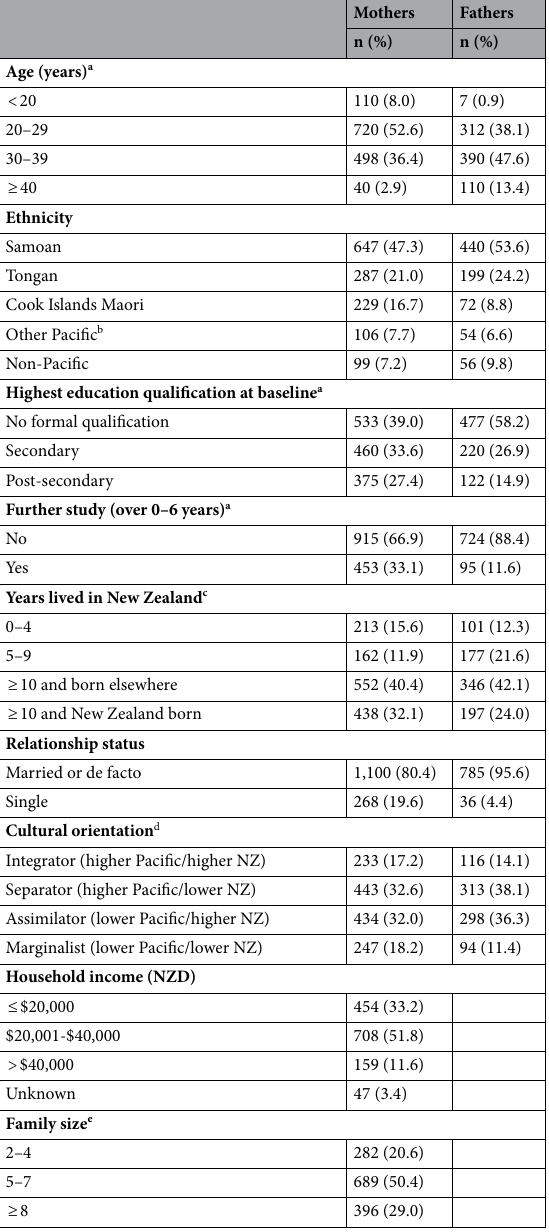
Table 1. Baseline sociodemographic characteristics of mother (6-weeks measurement wave, N = 1,368) and father (12-months measurement wave, N = 821) participants. a 2 (0.2%) values missing for fathers; b includes those identifying equally with two or more Pacific Island groups; c 3 (0.2%) values missing for mothers; d 11 (0.8%) values missing for mothers; e 1 (0.1%) values